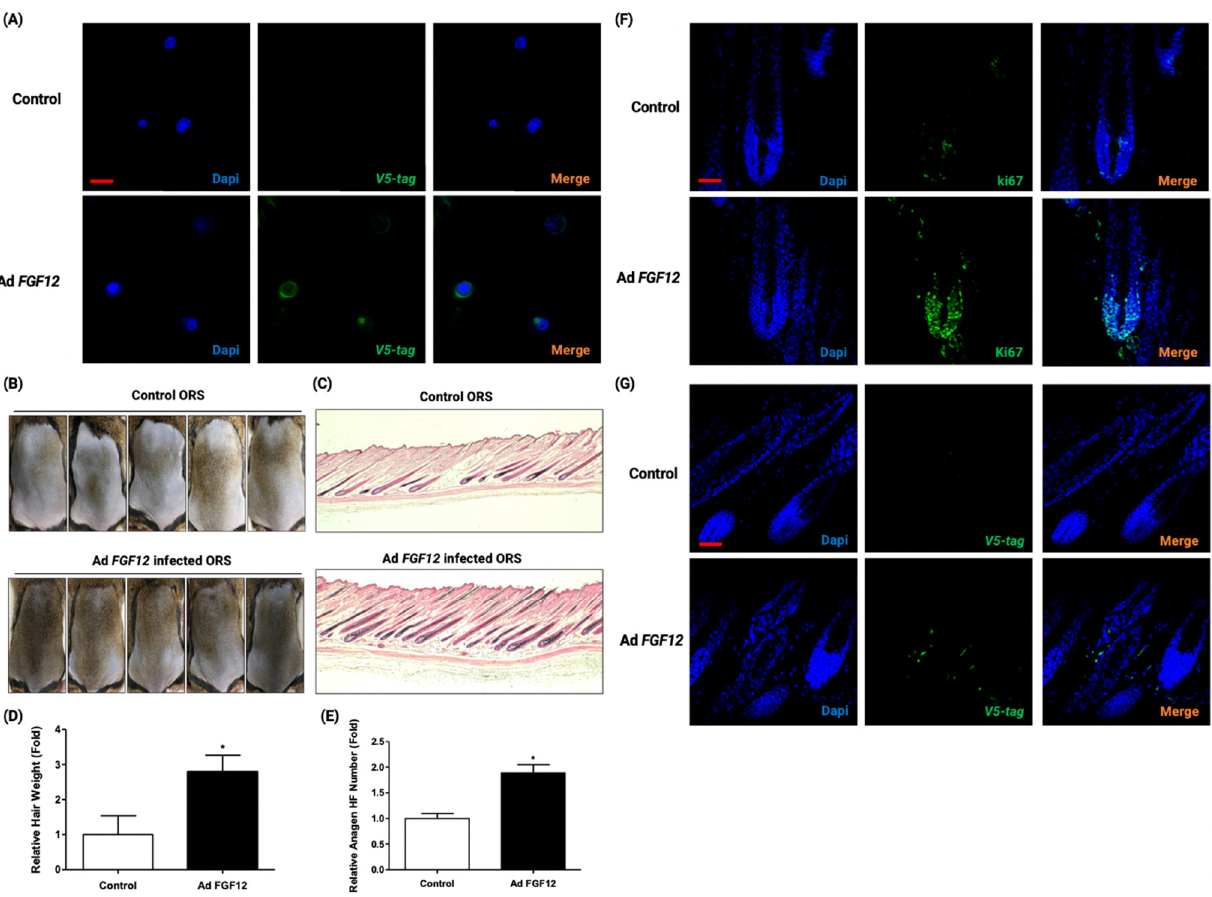
Figure 5. FGF12 overexpressing ORS cell injection in mouse dorsal skin at telogen phase promoted anagen induction in vivo. ( A ) Immunofluorescence staining with anti-V5-tag antibody in Adenovirus (Ad)-infected ORS cells confirmed that the virus infection was successfully carried out. Green indicates FGF12 and blue indicates DAPI. ( B ) The telogen-anagen transition was observed in C3H/HeN mouse. ORS cells were infected with LacZ Ad as control, and FGF12 Ad-infected ORS cells were used for the test group. Each group of Ad-infected ORS cells was injected into mouse dorsal skin and the images were taken after 14 days of injection; n = 5. ( C ) Hematoxylin and eosin (H&E) staining of the mouse dorsal skin in each group is shown. ( D ) The hair weight of each group was measured and quantified; n = 5. ( E ) Quantification of anagen follicle number from H&E staining indicated that overexpression of FGF12 in ORS cells promoted hair growth. ( F ) Immunofluorescence staining with the anti-ki67 antibody of mouse dorsal tissue samples harvested from telogen-to-anagen transition assay. ( G ) Immunofluorescence staining with the anti-V5-tag of mouse dorsal tissue samples harvested from telogen-to-anagen transition assay. All data expressed as mean ± standard error (* p < 0.05 versus the control group). scale bar = 50 μ m.